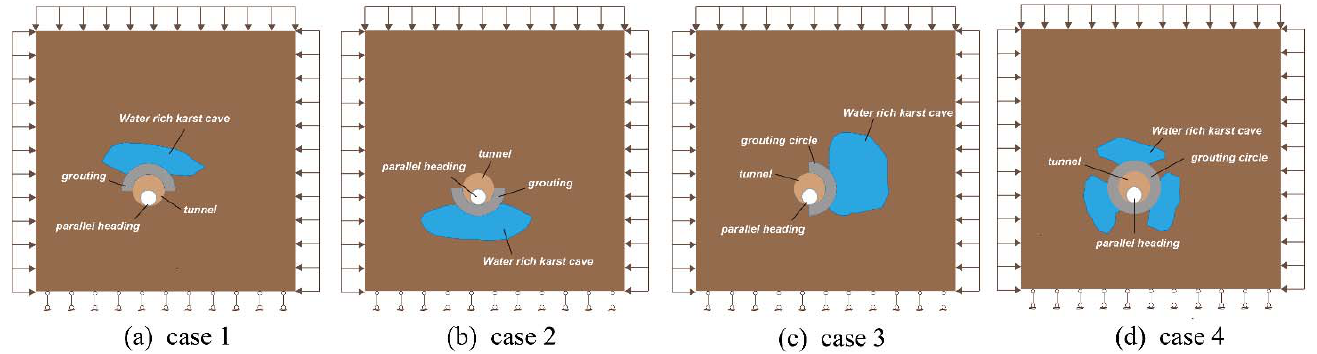
Figure 4. Schematic diagram of the numerical calculation model for different relative positions of tunnel and cave: ( a ) tunnel under the cave; ( b ) tunnel up through the cave; ( c ) tunnel side crossing the cave; ( d ) tunnel through the cave cluster. the cave; ( d ) tunnel through the cave